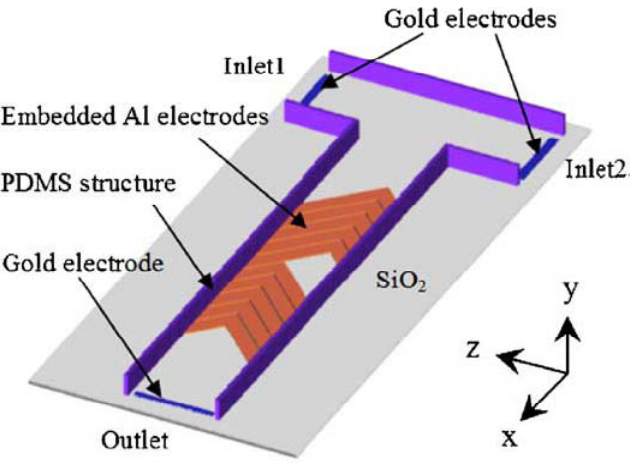
Figure 22. A “T” shape microchannel with aluminum electrodes embedded on the bottom wall to enhance mixing (from Wu and Liu [44]).